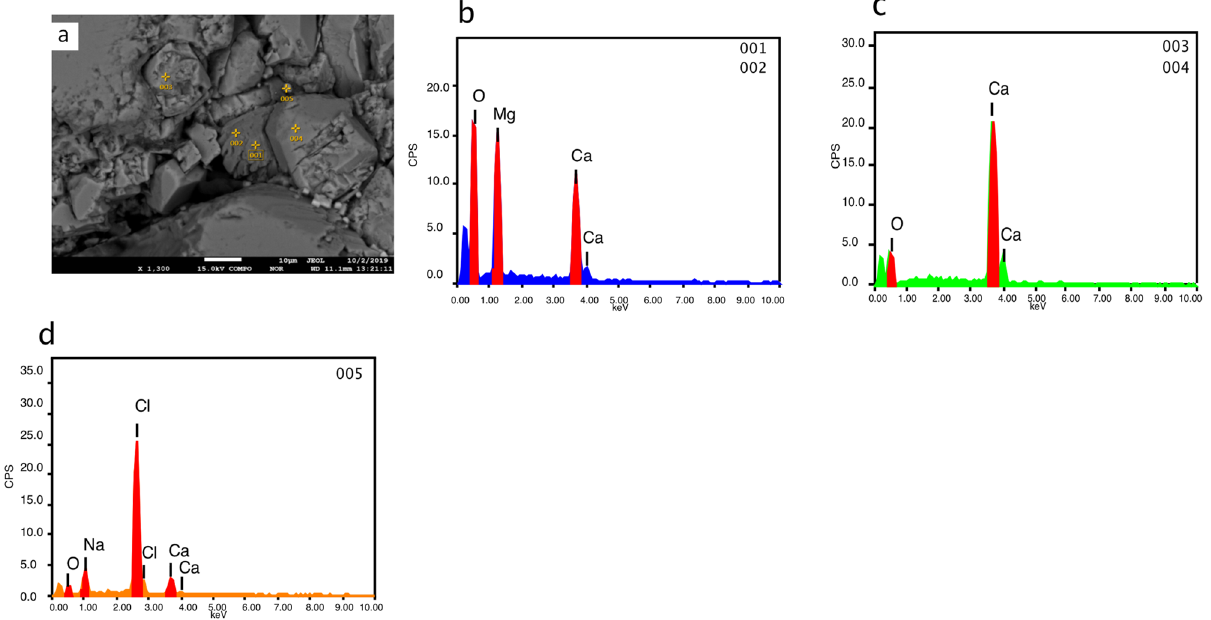
Figure 8. EPMA single point analyses of MV1 sample. ( a ) backscattered electron image of rhombohedral dolomite engrained within calcite matrix. The EDS chemical analysis shows the elemental composition of: ( b ) dolomite (points 001 and 002), ( c ) calcite (points 003 and 004), and ( d ) halite (point 005).